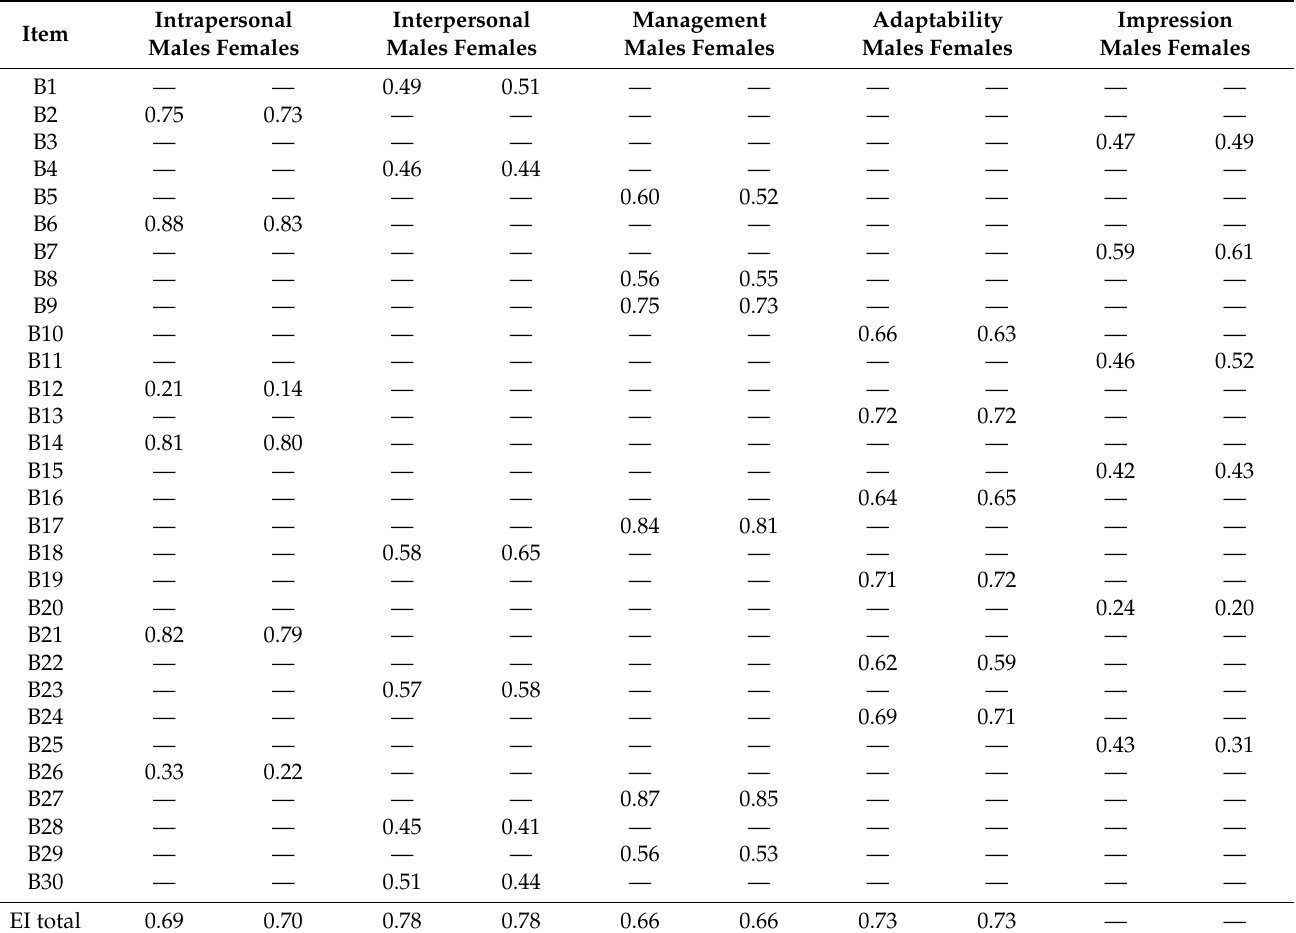
Table 4. Standardized solutions of the model for males and females. The last line shows the gamma parameters. Intrapersonal Item Males Females